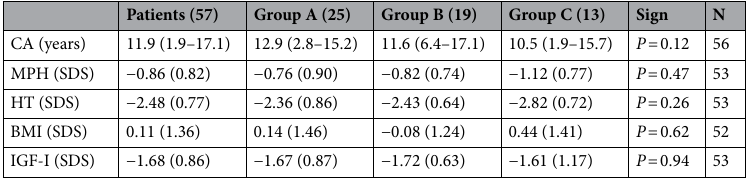
Table 1. Baseline characteristics expressed as mean (SD) or median (min–max). CA chronological age, MPH mid-parental height, HT height, BMI body mass index, IGF-I insulin-like growth